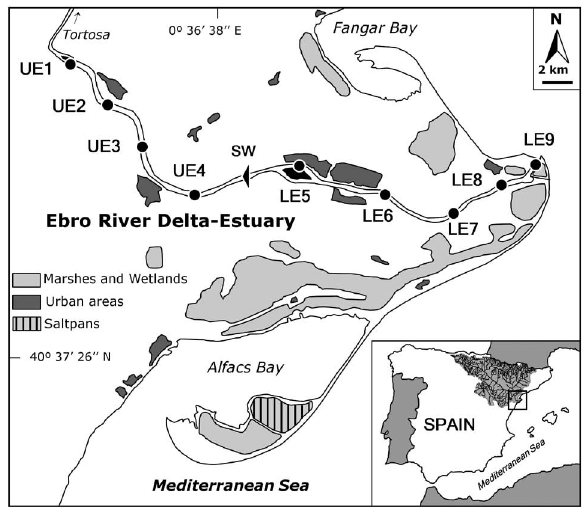
Fig . 1. – Location of the Ebro estuary and its deltaic plain showing the nine sampling stations. UE, upper estuary stations; LE, lower estuary stations; SW, position of the salt wedge